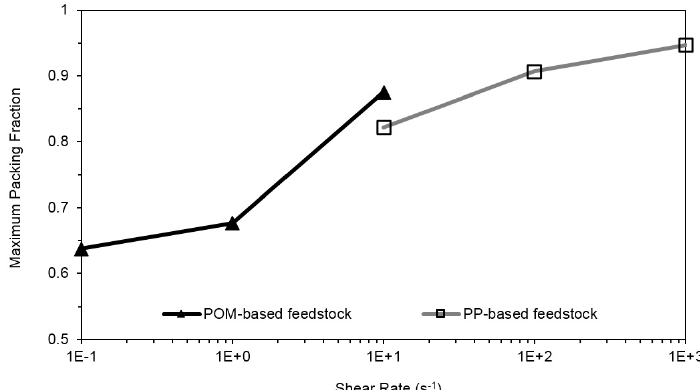
Figure 9. Maximum packing fraction at different shear rates for POM-based and PP-based feedstock materials. Please note that lines are used to group together the data from different materials and do not represent any model.